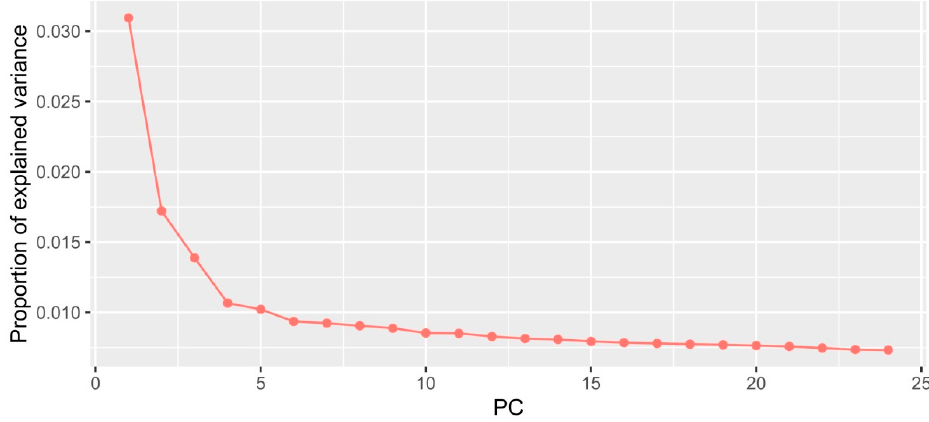
Figure 3. Proportion of variance explained by each PC. Then, all SNPs were regressed against the retained ordination axes, and outlier SNPs were selected based on their significant correlation with these axes. The Manhattan plot in Figure 4 shows the statistical significance score for each SNP. In total, 423 outlier SNPs were identified using the false discovery rate (FDR) cut-off with a q -value < 0.05.